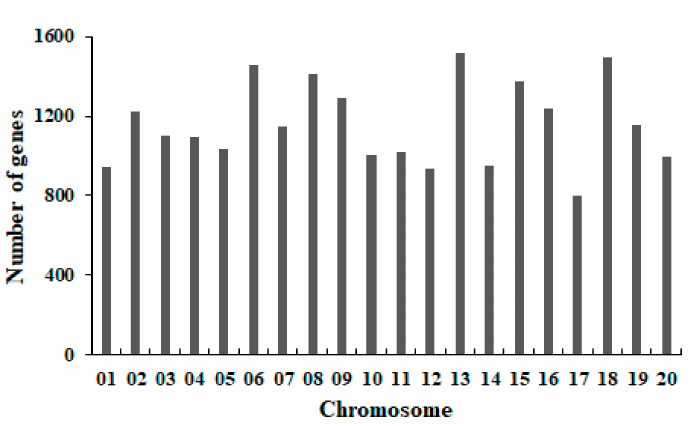
Figure 4. The gene distribution on each